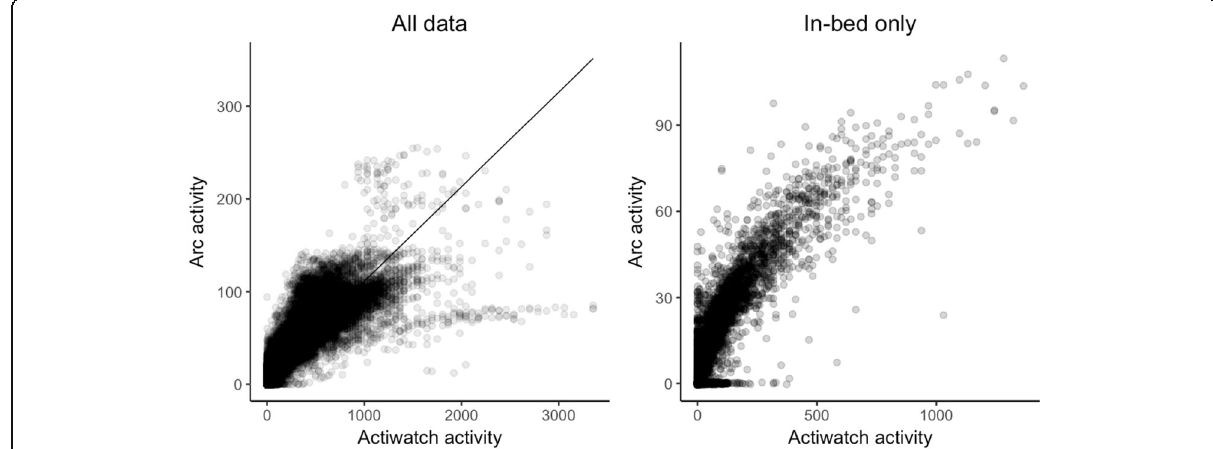
Fig. 2 (Left) Minute-by-minute absolute activity of Arc and Actiwatch as recorded from all subjects over 48 h (82,587 data points). (Right) Minute-by-minute